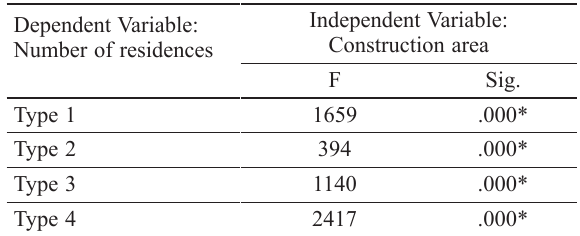
Independent Variable: Construction